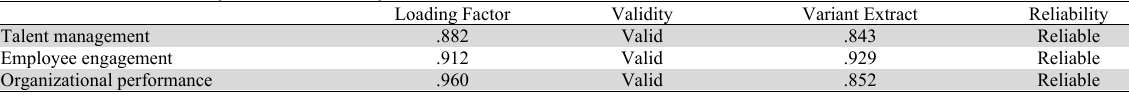
The Results of Validity and Reliability